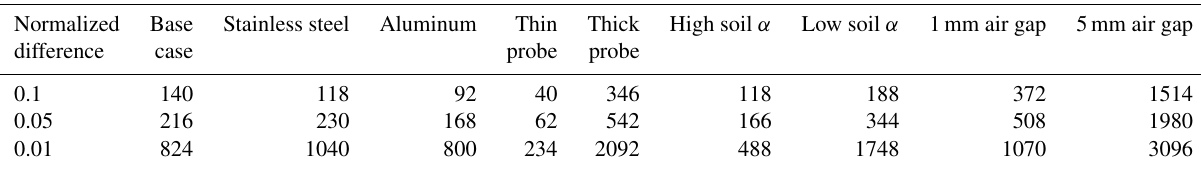
Table 2. Time (in seconds) needed for the DTP sensor to approach a soil temperature of 0.1, 0.05, and 0.01 times their initial differences, depending on various probe and environmental parameters. The parameters for the base-case (Bc) scenario are changed one at a time to simulate various cases (Fig. 4). Table 1 provides the values of the various parameters for each